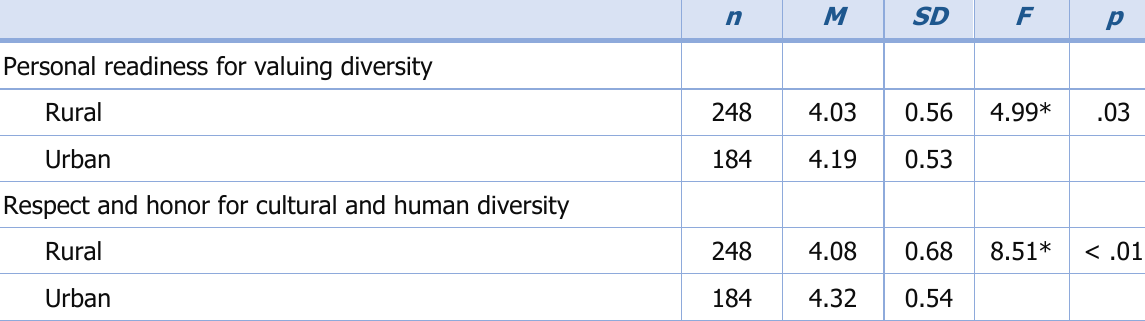
Table 5. Differences Between 4- H Extension Agents’ Perceived Importance of the AEO Domain’s Sensitivity Components and the Rural/Urban Characteristic